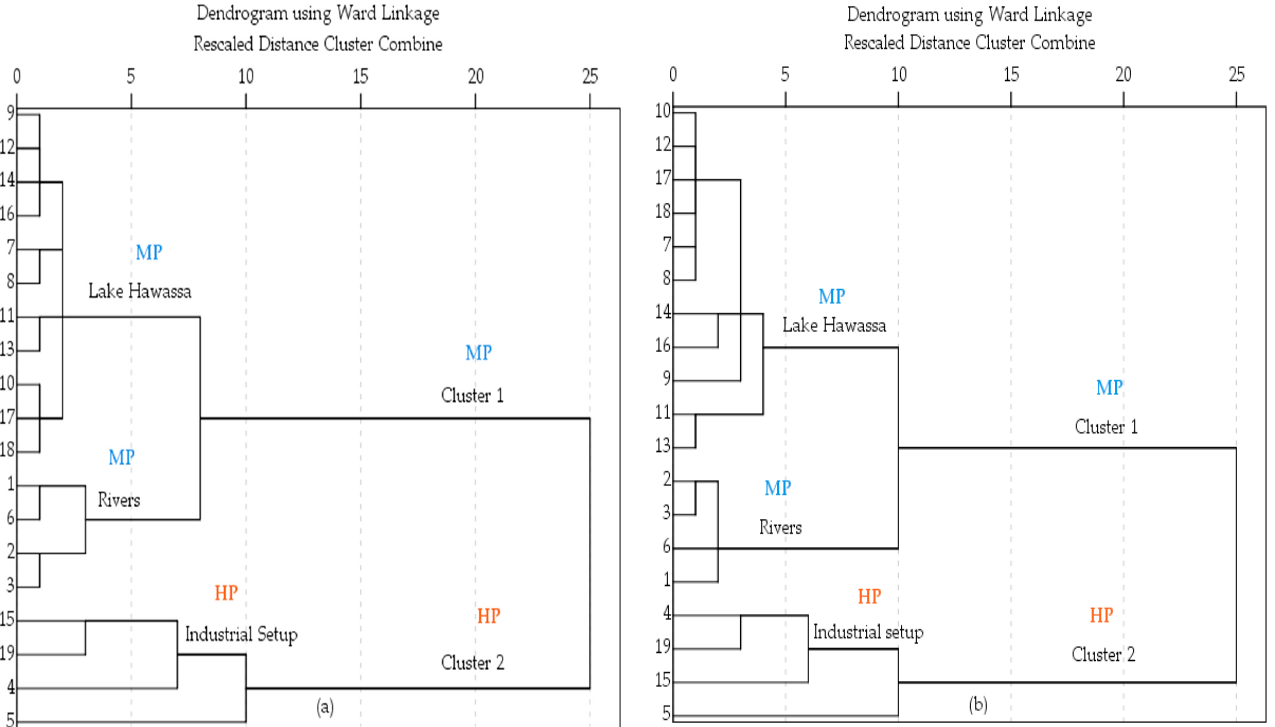
Figure 2. Dendrogram for LHW based on Ward’s method showing the clustering of 19 monitoring stations into two significant clusters for both dry ( a ) and wet ( b ) seasons.